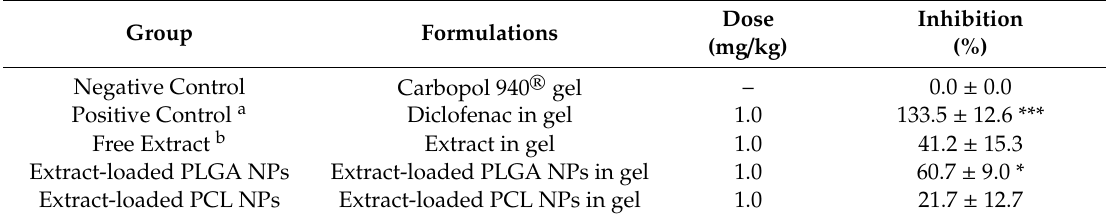
Table 3. AIA of topically applied extract formulations on the carrageenan-induced rats’ hind paw oedema model (mean ± S.E.M, n = 5, unless otherwise indicated; a— n = 6; b— n = 8, * p < 0.05 and *** p < 0.001, when compared to negative control).